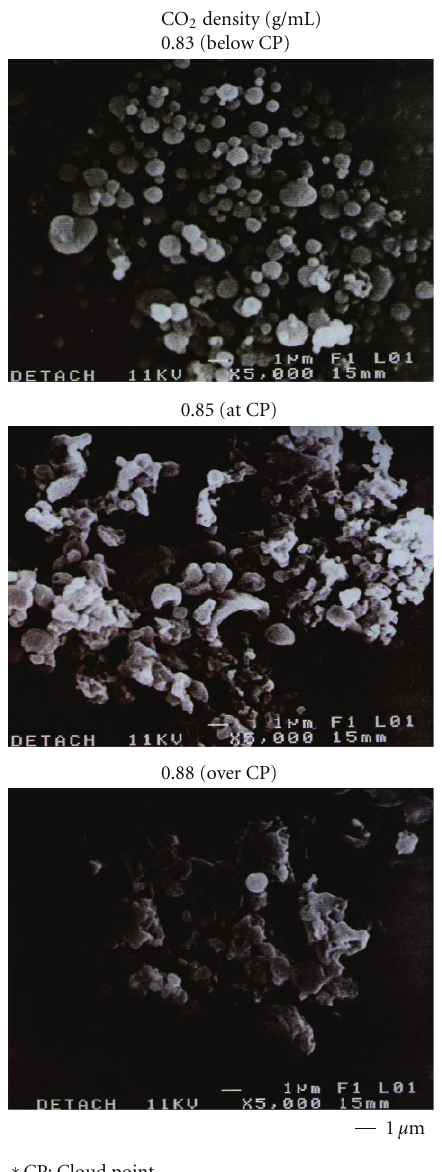
Figure 12: SEM images of polymer particles obtained from the heterogeneous state below the cloud point, the state at the exact cloud point, and the homogeneous state over it. POA/DAA = 7/3, PA/DAA =